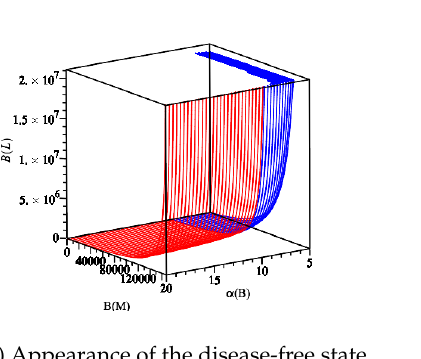
= 1). This causes reaches its threshold value ( R wt 0 0